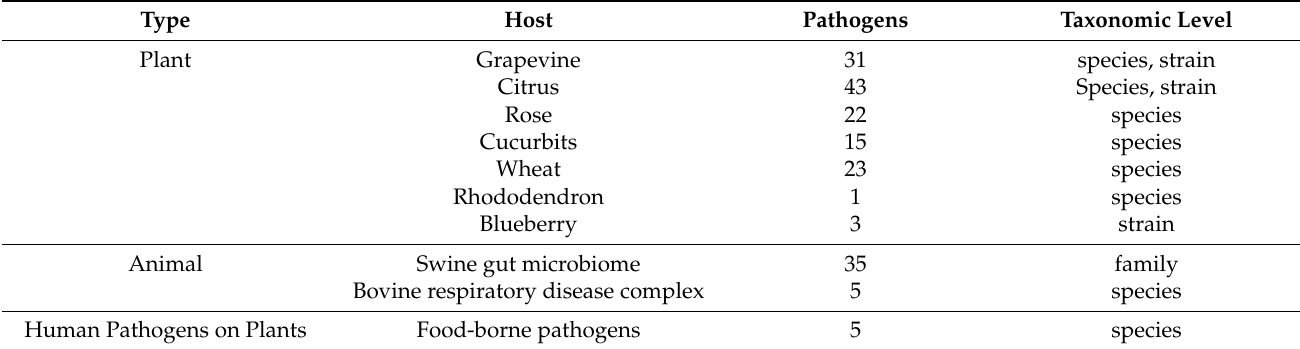
Table 2. Hosts and number of pathogens with validated e-probe sets currently in the MiFi ®